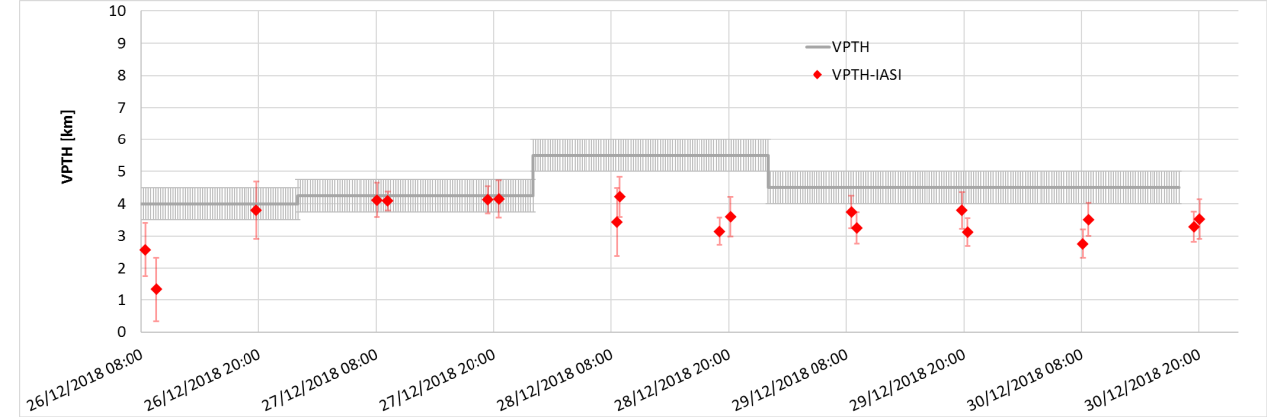
Figure 8. VPTH used for the SEVIRI, MODIS, VIIRS and TROPOMI retrievals (gray line) and VPTH used for IASI SO 2 retrievals.